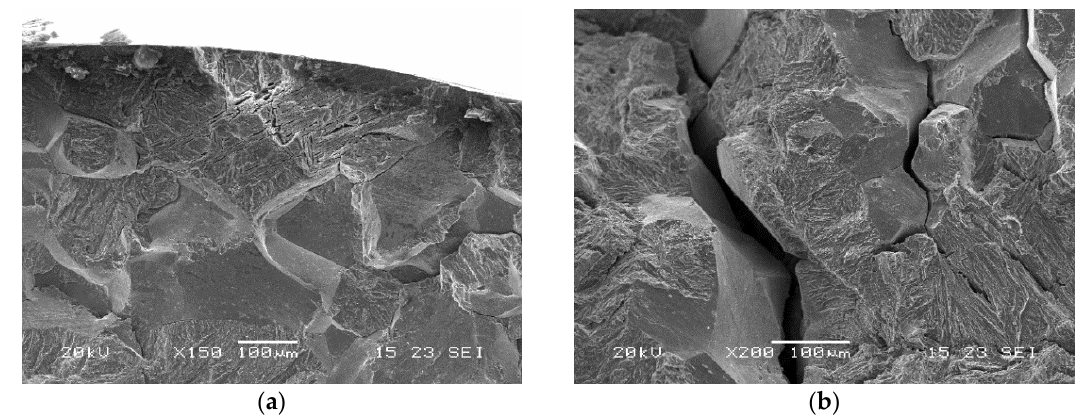
Figure 8. SEM images of fracture surfaces of a group I sample after SSRT test of immersion in NACE A solution ( a ) edge, ( b ) core.